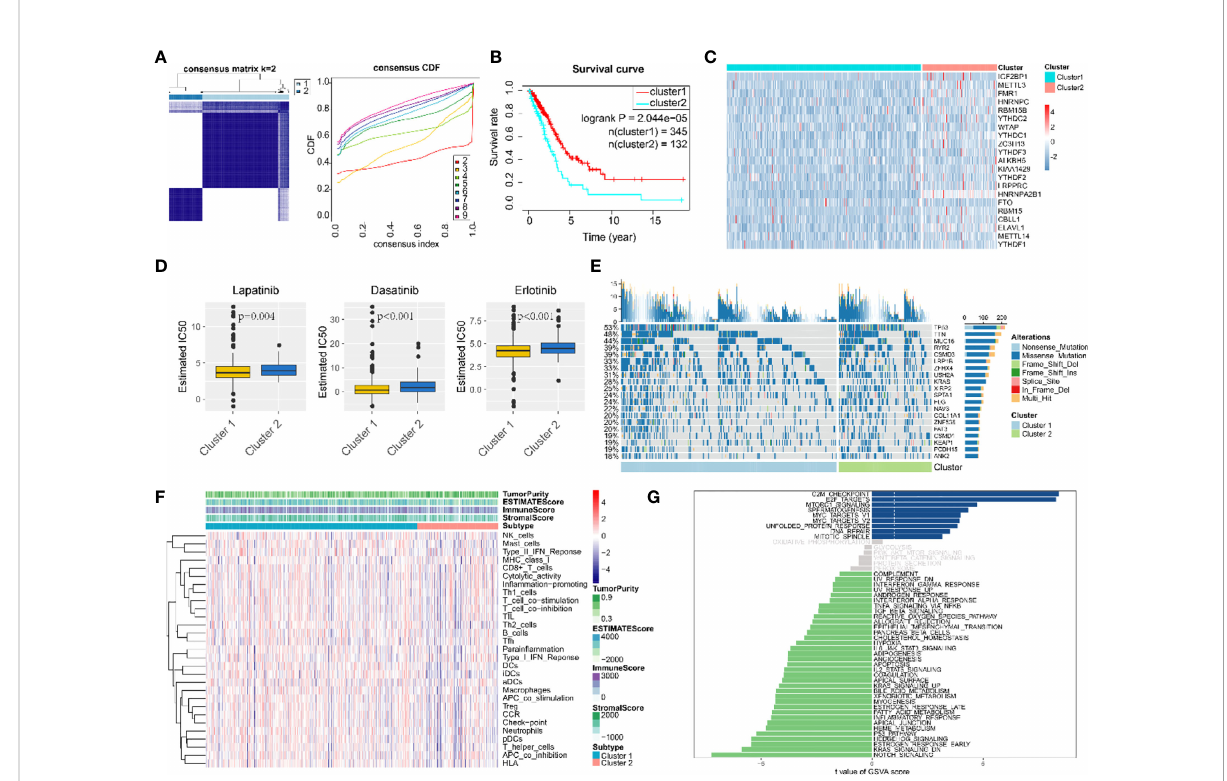
FIGURE 3 Consensus clustering classi fi ed LUAD patients into two clusters. (A) Consensus matrix (K = 2) and consensus cumulative distribution function of consensus clustering. (B) Overall survival differences among two consensus clusters. (C) Expression differences of 21 m 6 A-regulated genes among two consensus clusters. (D) Drug sensitivity estimation of three antineoplastic agents among two consensus clusters. Differences between groups were tested with the Wilcoxon rank-sum test. (E) Mutation panoramagram for single-nucleotide polymorphism analysis within two consensus clusters. (F) Tumor purity, in fi ltration level of immune cells, and stromal cell proportion of LUAD tissues in two consensus clusters. (G) t value for GSVA enrichment scores among two consensus clusters. Blue bar graphs indicate pathways signi fi cantly enriched in cluster 1; green bar graphs indicate pathways signi fi cantly enriched in cluster 2; grey bar graphs indicate non-signi fi cant